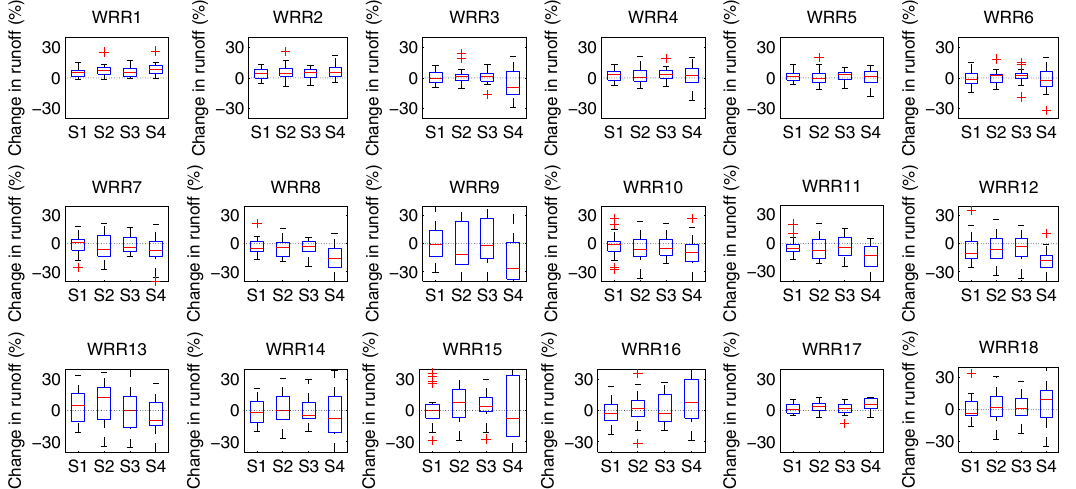
Figure 6. Area-averaged changes in runoff in the 18 water resource regions (WRRs) in the future scenarios. The four future scenarios are denoted by S1 (RCP4.5/2030s), S2 (RCP4.5/2080s), S3 (RCP8.5/2030s), and S4 (RCP8.5/2080s) on the x axis. The vertical spread of the box–whisker plots shows the different results projected from the 20 GCMs, with the boxes covering the ranges from the 25% quartile to the 75% quartile of the distributions and the red lines within each box marking the median values. Points outside the whiskers are taken as extreme outliers and marked by plus signs.